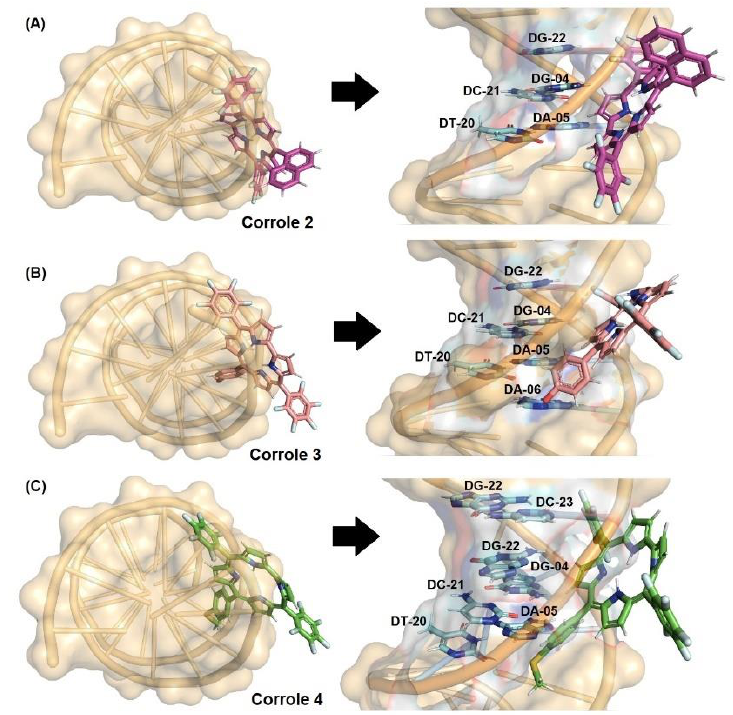
Figure 8. Best docking pose for ( A ) DNA: 2 , ( B ) DNA: 3 , and ( C ) DNA: 4 in the minor groove. Selected nitrogenated bases and corroles are in stick representation in cyan, pink, beige, green, and brown, respectively. Elements’ color: hydrogen: white; oxygen: red; nitrogen: dark blue, fluorine: light blue, and sulfur: yellow.